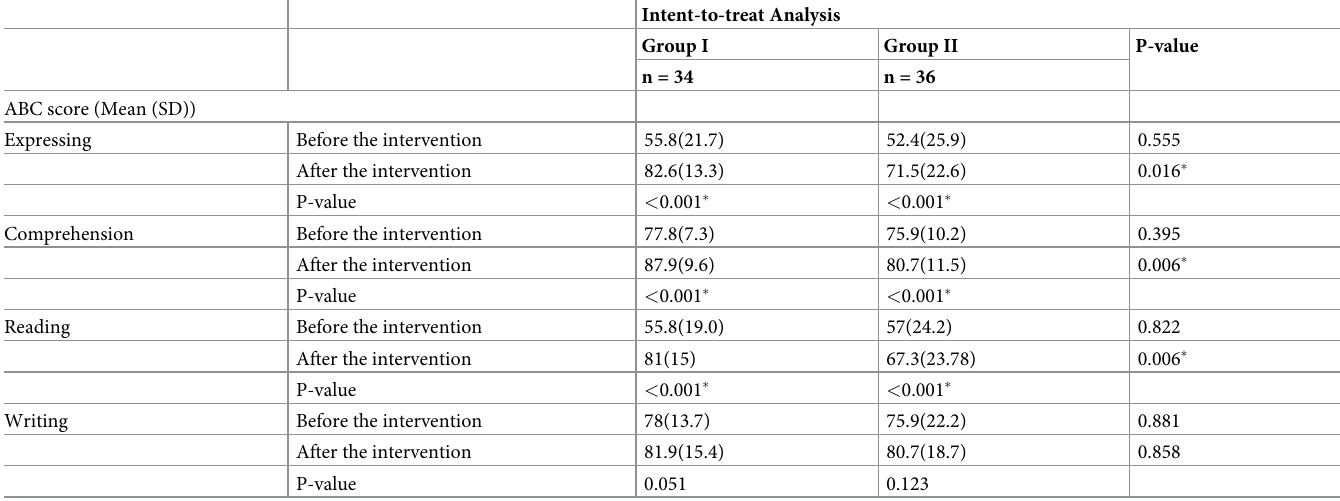
Table 2. Comparison of the ABC scores before and after the intervention in both groups.